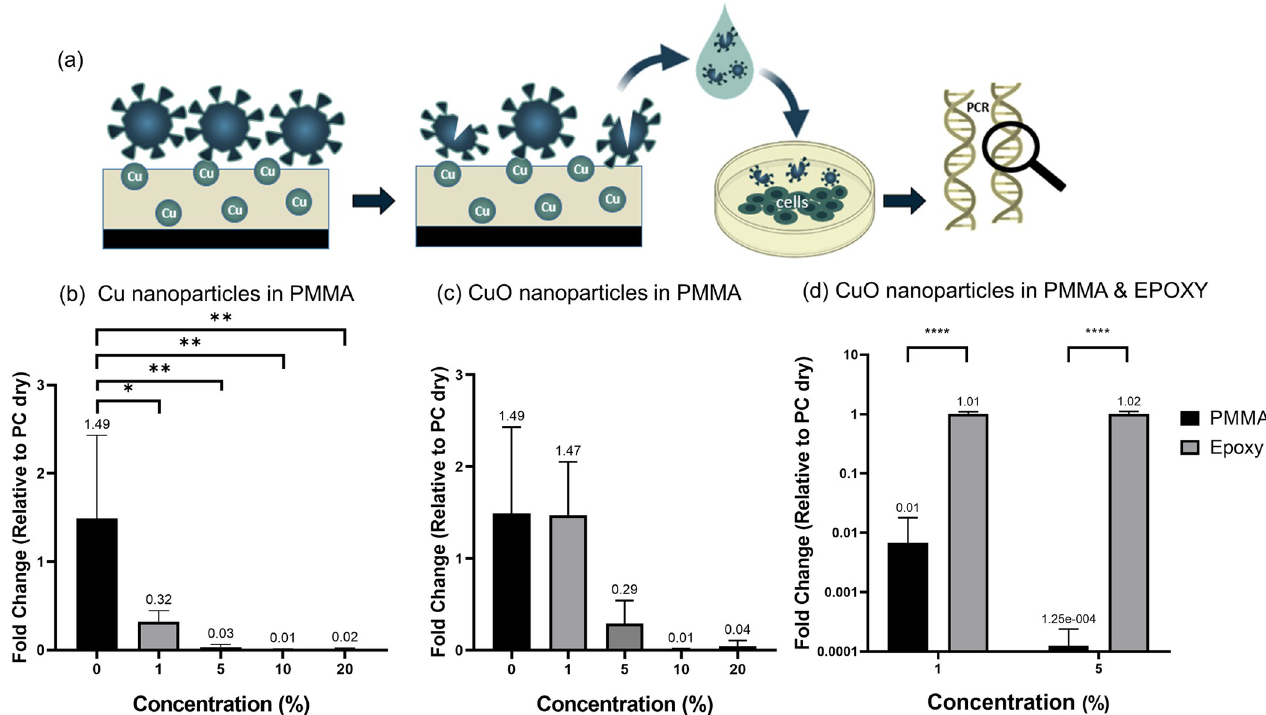
Fig 1. (a) Schematic description of the experimental protocol for the assessment of the antiviral efficiency of the coating (b) antiviral effect of copper NPs suspended in PMMA, (c) effect of CuO NPs suspended in PMMA on viral content (d) antiviral effect of the polymer matrix. Experiments were performed in triplicate. Analysis of variance with a Tukey post-hoc test was performed for statistical analyses. Differences between datasets were considered significant for p < 0.05.